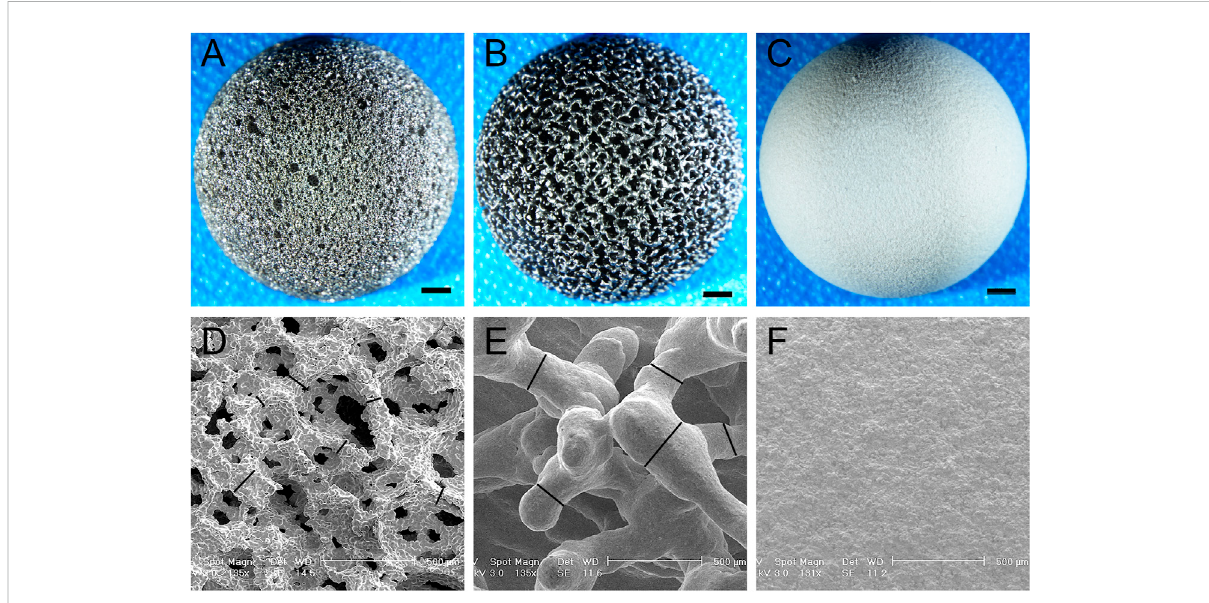
FIGURE 3 Light and electron microscopy images of the acetabular cup of three materials. (A – C) Light microscope images of the acetabular cup of three materials at 2 mm scale. (A) Sintered porous titanium alloy acetabular cup; (B) 3D-printed porous titanium alloy acetabular cup, and (C) HA-coated titanium alloy acetabular cup. (D – F) Electron microscopy images of the acetabular cup of three materials, the scale is 500 μ m. (D) Sintered porous titanium alloy acetabular cup. A spatial porous structure similar to cancellous trabeculae can be observed, the black lines are marked as wire diameter in the fi gure; (E) 3D-printed porous titanium alloy acetabular cup. The black lines are marked as wire diameter, comparison with a wire diameterofsinteredporoustitaniumalloy p < 0.001. (F)